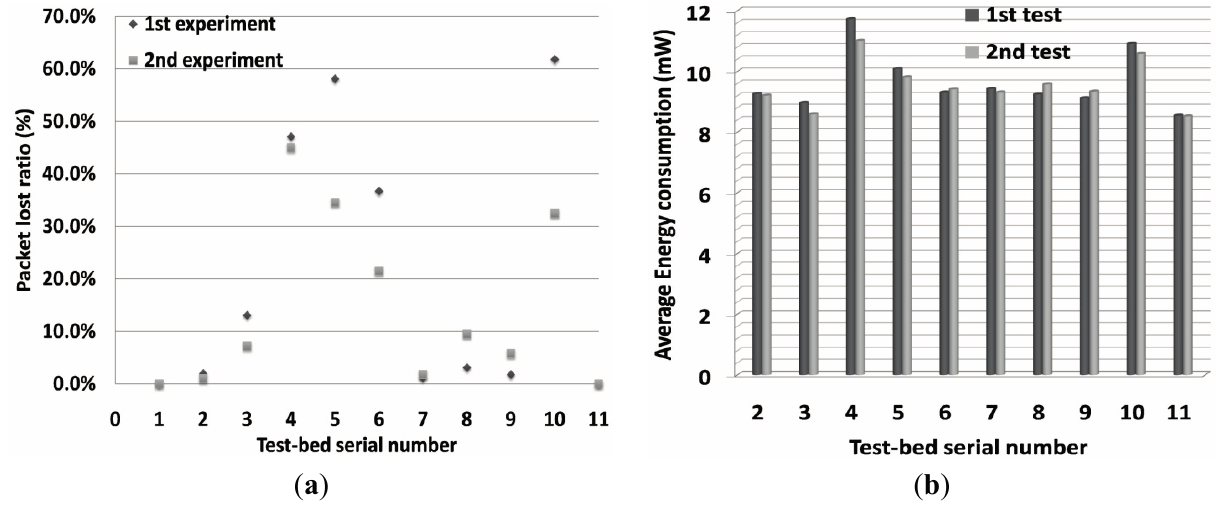
Figure 8. ( a ) Packets lost ratio in the field tests of 11 IWoTCore nodes; ( b ) Average energy usage of the testbeds in the 1st and 2nd